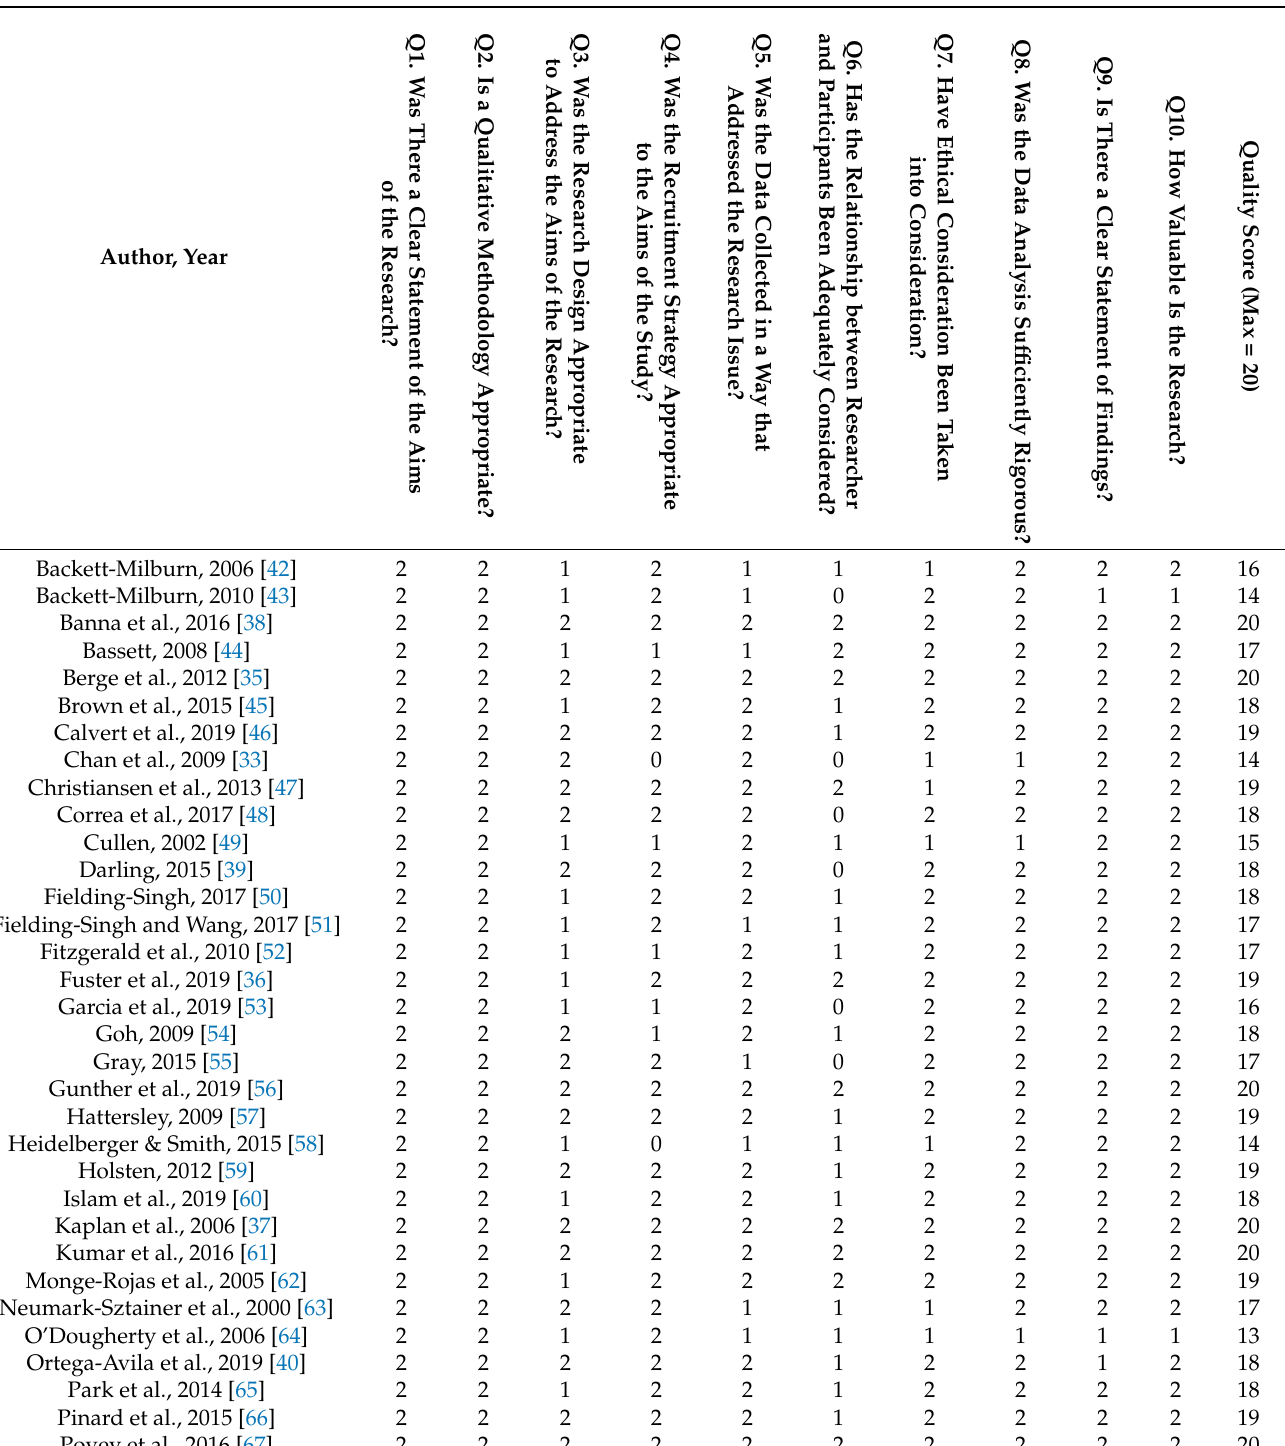
Table 3. Quality assessment of reviewed studies (2 = Complied, 1 = Cannot tell, 0 = Not